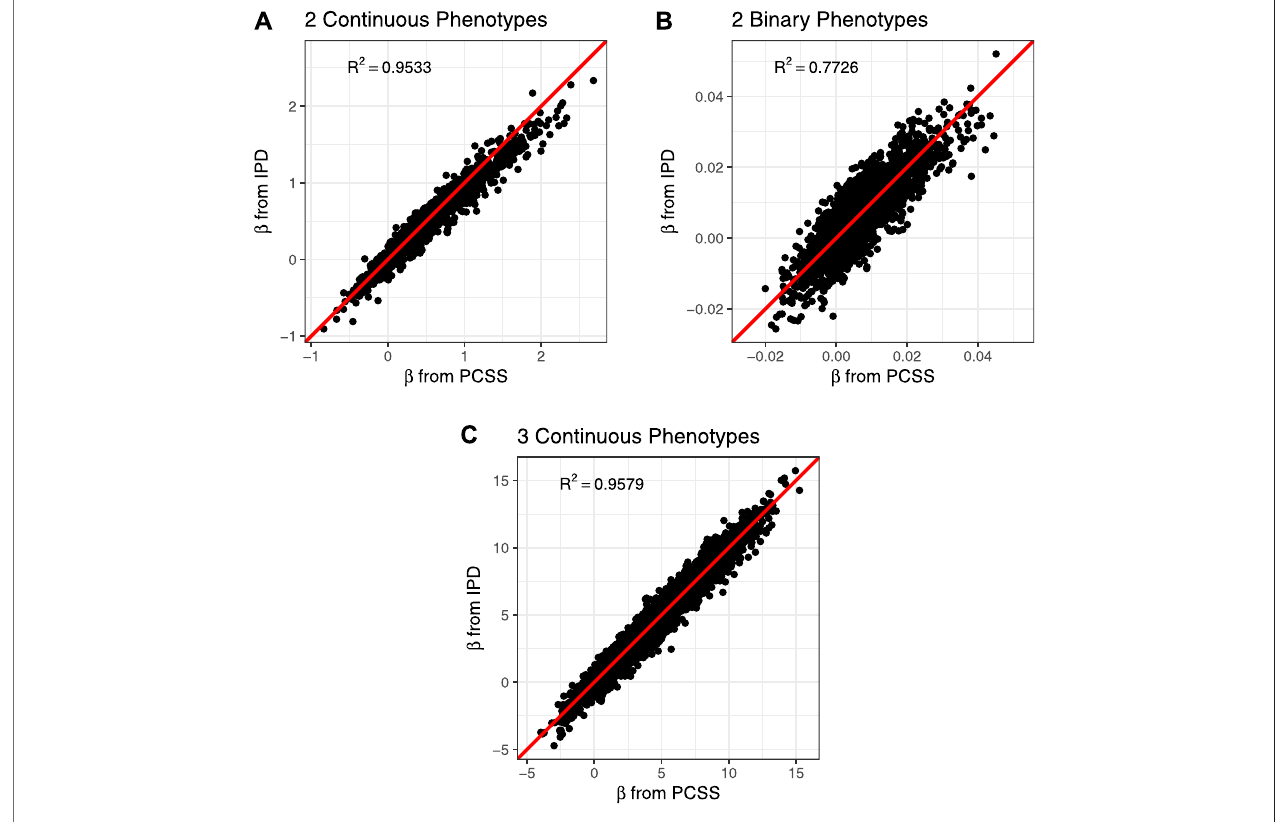
FIGURE 2 | Comparison of slope coef fi cients from a simulation study approximating a covariate adjusted linear model for a product of phenotypes using pre- computed summary statistics (PCSS) and individual participant data (IPD). (A) Modeling the product of two continuous phenotypes while adjusting for a binary and a continuous covariate. (B) Modeling the product of two binary phenotypes while adjusting for a binary and a continuous covariate. (C) Modeling the product of three continuous phenotypes while adjusting for a binary covariate.